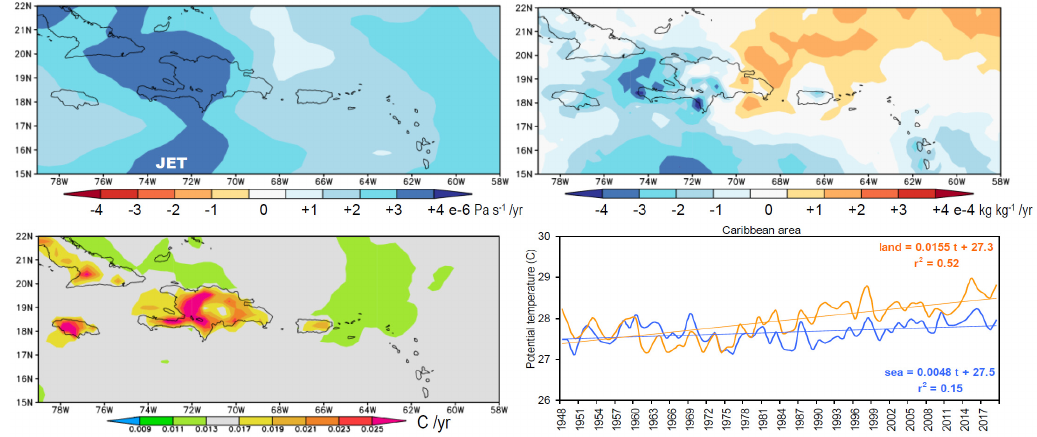
Figure A1. Trend analysis of ECWMF5: (top row) 500 hPa vertical motion and specific humidity, blue upward moistening; (lower row) surface air temperature and annual time series over land and sea.